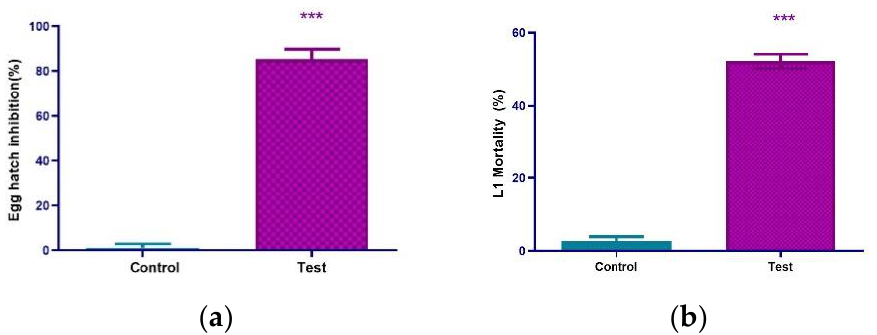
Figure 4. Effect of ACF on C. elegans . ( a ) Percentage of egg hatch inhibition was calculated 15 h after treatment of eggs in the M9 buffer with an equal volume of ACF; ( b ) Percentage of Mortality was calculated after 24 h of L1 larvae with ACF. Eggs and Larvae untreated served as control. Values are means ± standard deviation of three replicates. Significance at *** p < 0.001; Paired t -test.